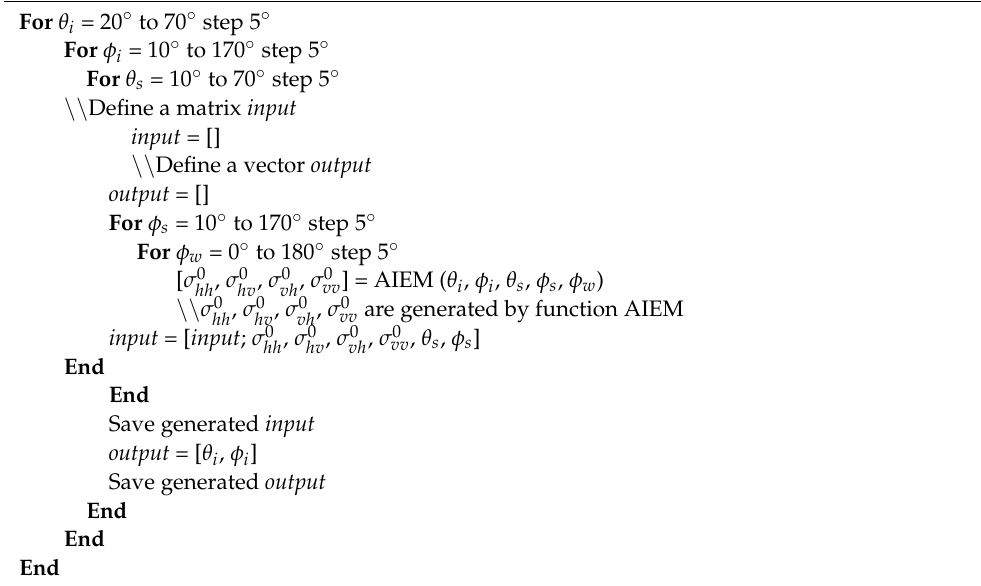
Algorithm 1 Generation of Training Data by the AIEM